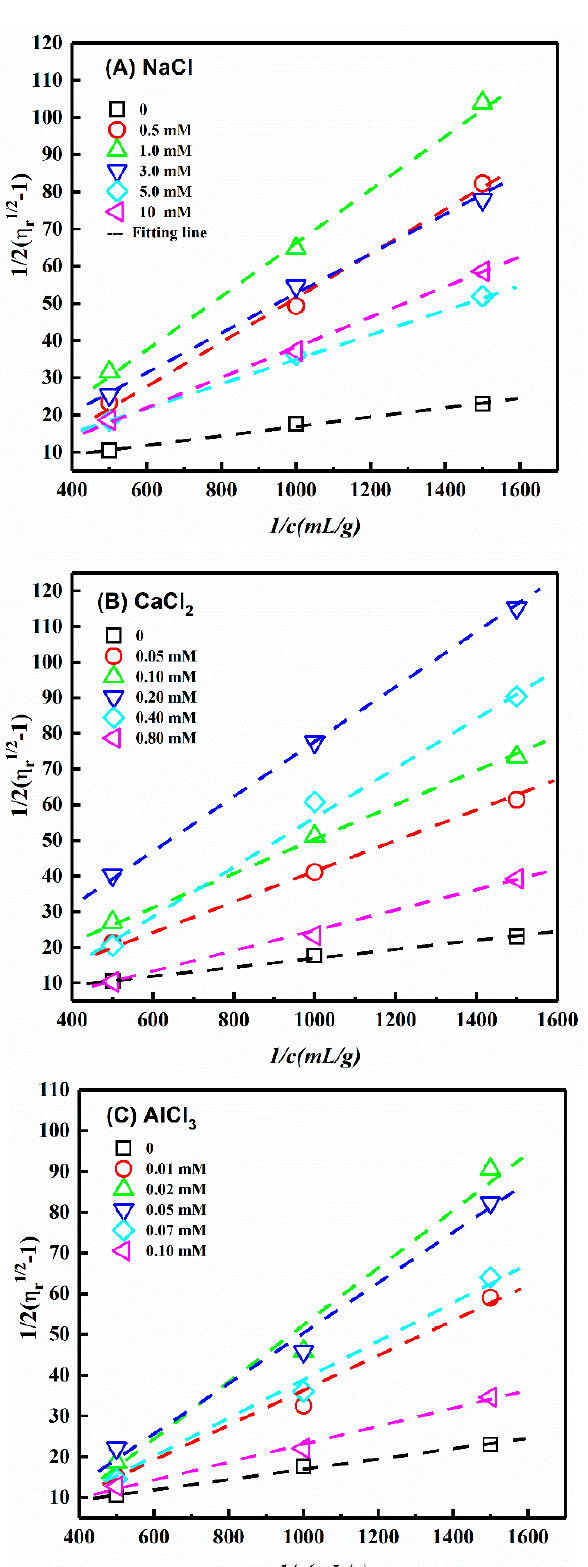
Figure 5. Fedors plots for CNC-A suspensions with different concentration of ( A ) NaCl, ( B ) CaCl 2 , and ( C ) AlCl 3 . Table 3. Intrinsic viscosities of CNC-A suspensions and calculated aspect ratio of CNC with various NaCl, CaCl 2 , and AlCl 3 concentrations.